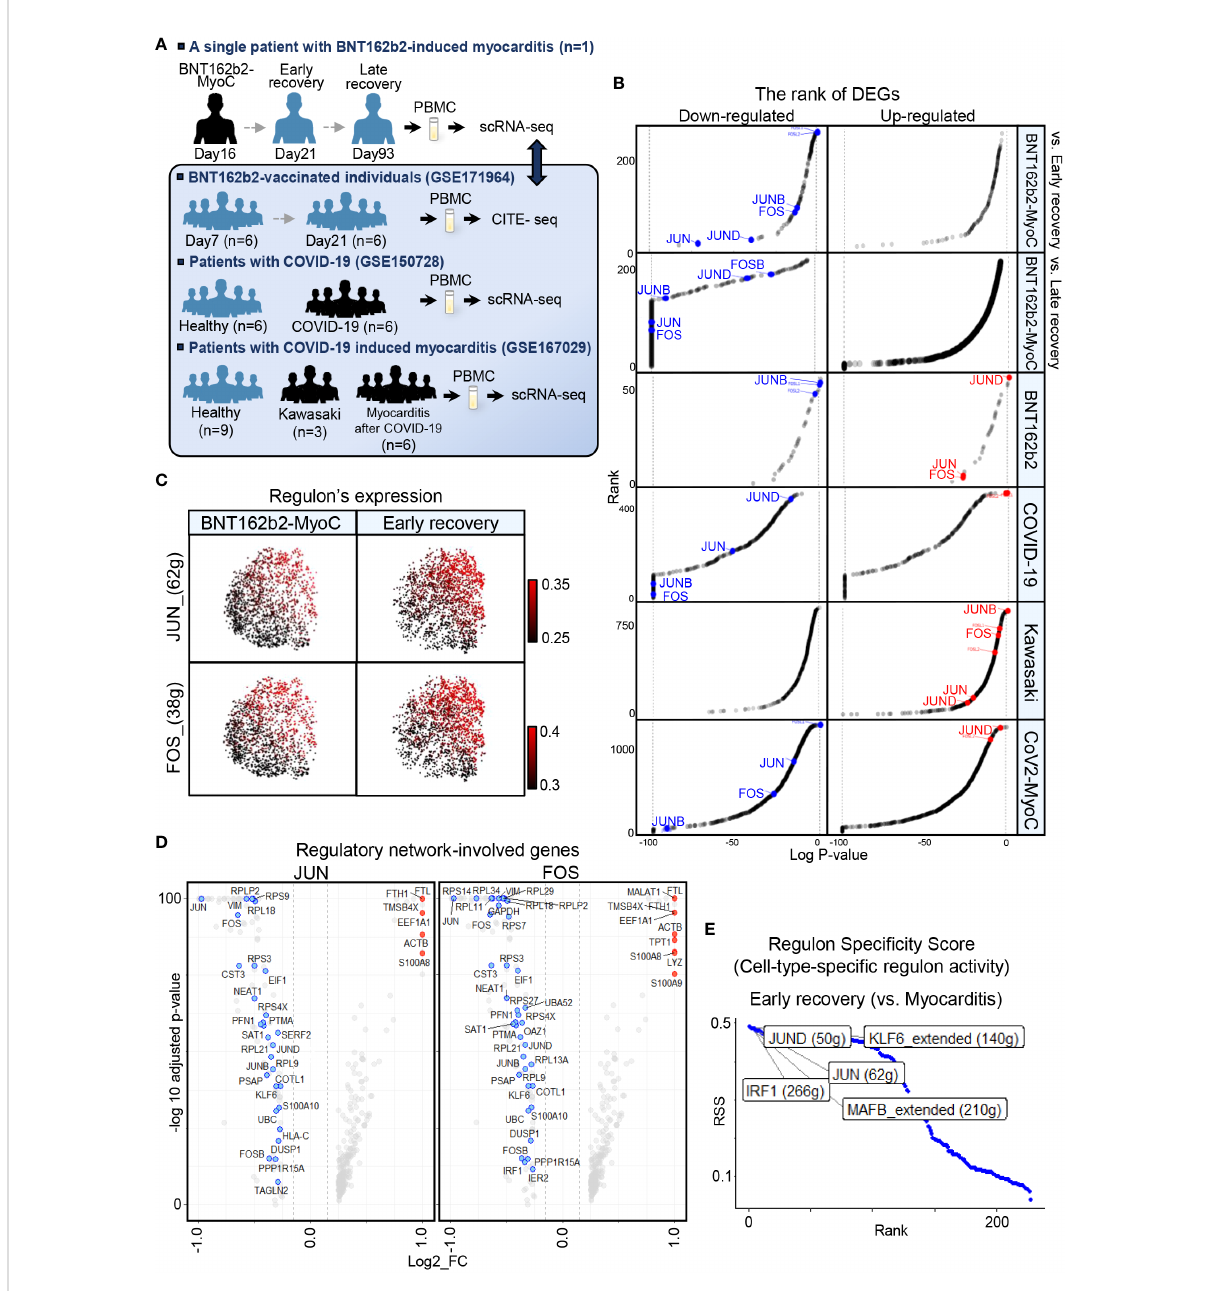
FIGURE 3 JUN, FOS are the Most Down-regulated in Classical Monocytes in BNT162b2-MyoC Stage. (A) A schematic of the experimental pipeline. PBMCs were obtained from the BNT162b2 vaccinated patient in the stage of myocarditis (day16), early recovery(day21), and late recovery(day93), respectively. The samples were performed single-cell RNA-seq and integrated to one dataset with Harmony. Publicly available datasets of PBMCs from BNT162b2- vaccinated individuals day7 and day21 after primary vaccination (GSE171964), PBMCs from healthy individuals and patients with COVID-19(GSE158055), and PBMCs from control group, patients with Kawasaki, and patients with COVID-19-induced myocarditis (CoV2-MyoC) were explored to understand the transcriptomic features of classical monocytes in more depth. (B) Log adjusted p-value (vertical axis) of DEGs of Classical monocytes in BNT162b2- MyoC plotted against the rank of average expression levels (vertical axis). The expression of AP-1(composed with JUN, JUNB, JUND, FOS, and FOSB. (C) UMAP showing expression levels of regulons of JUN and FOS in classical monocytes in BNT162b2-MyoC and in early recovery stage. (D) Volcano plots showing genes involved in regulatory network of JUN (left) and FOS (right) in M1 in DEGs of BTN162B2-MyoC group (horizontal axis) (E) Regulons with top 5 cell-type activity in classical monocytes in early recovery stage compared to